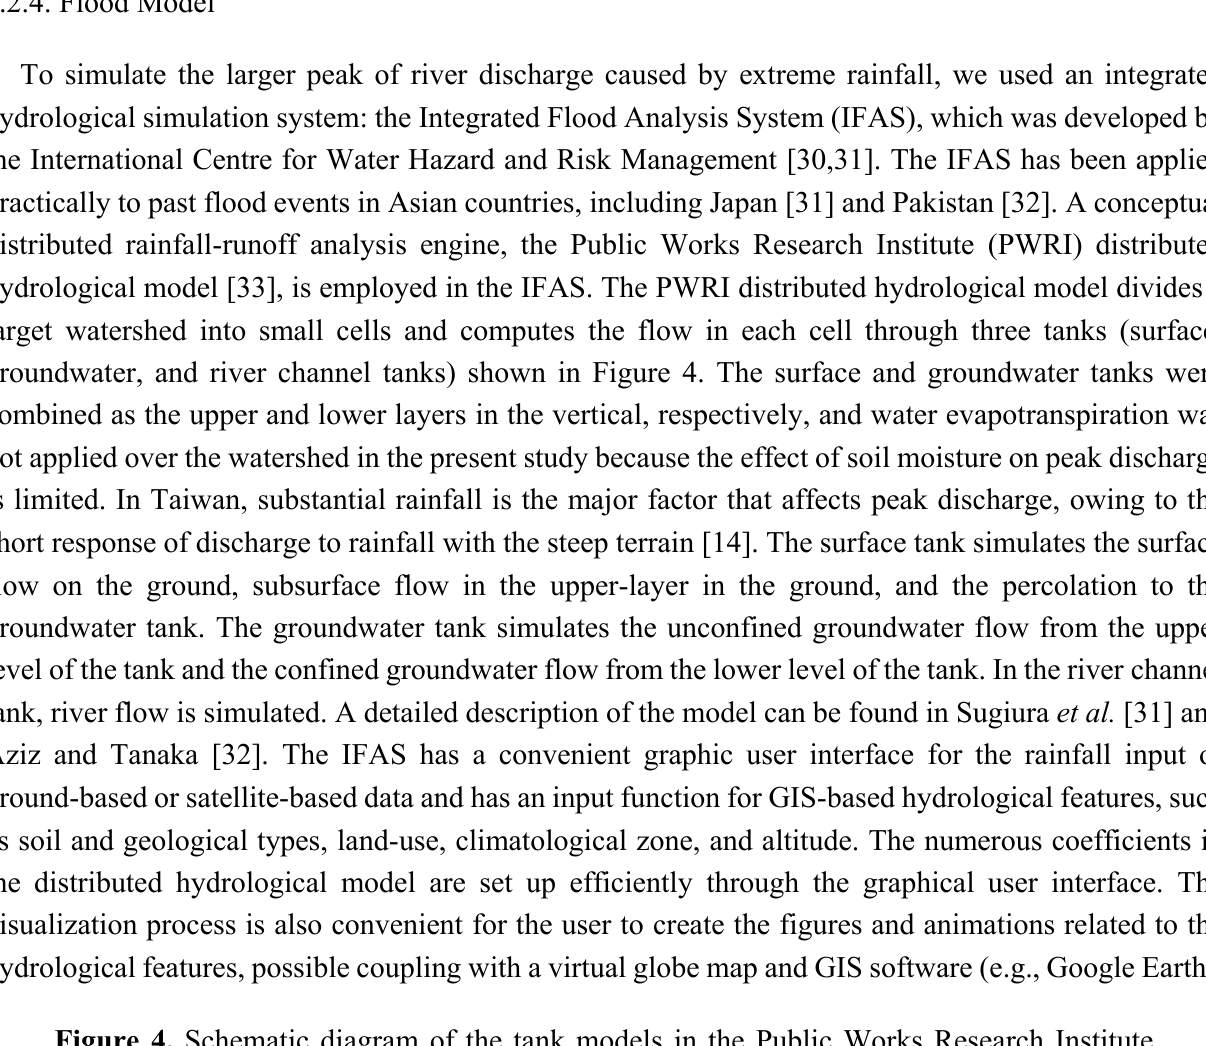
, Q , Q and Q eventually sf ri g 1 g 2